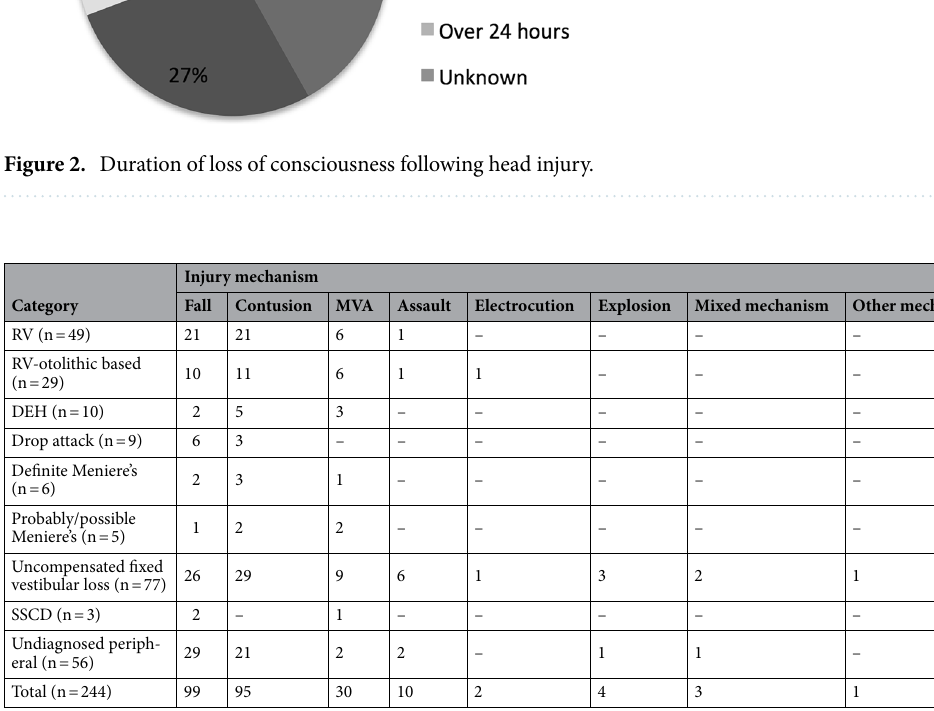
Table 3. Mechanism of head injury in the common types of peripheral vertigo. RV recurrent vestibulopathy, SSCD superior semicircular canal dehiscence, DEH delayed endolymphatic hydrops. Undiagnosed peripheral disorder represented those with a history suggestive for peripheral vestibular localization but defied classification into a recognized subgroup according to symptoms/signs/duration of vertigo etc.